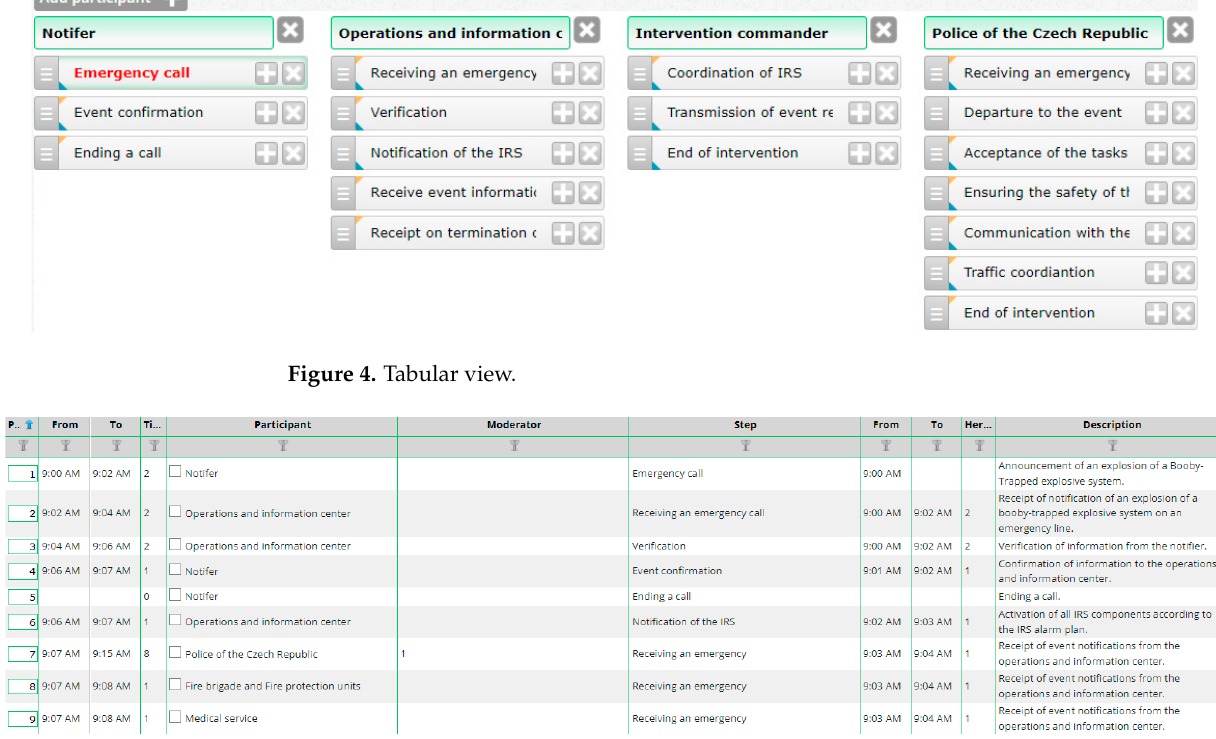
Figure 5. Overview of activities.